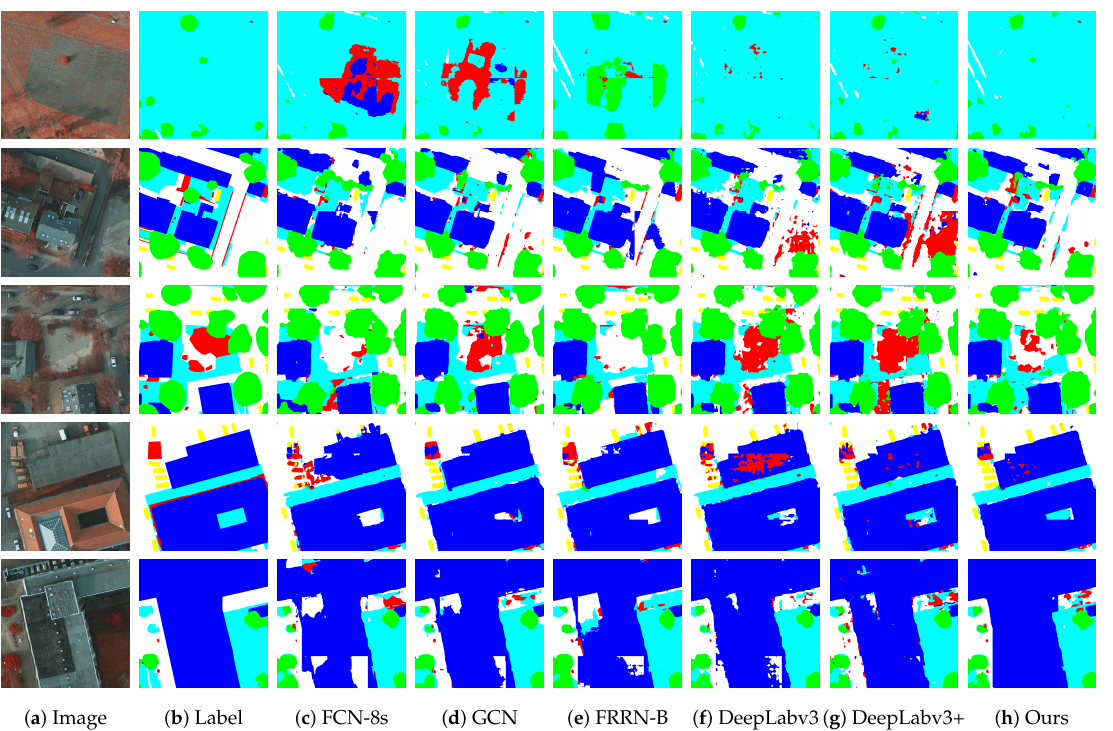
Figure 8. Visual comparisons with deep learning models of local evaluation on ISPRS Potsdam dataset (white: impervious surface, blue: building roof, cyan: low vegetation, green: tree, yellow: car, red: